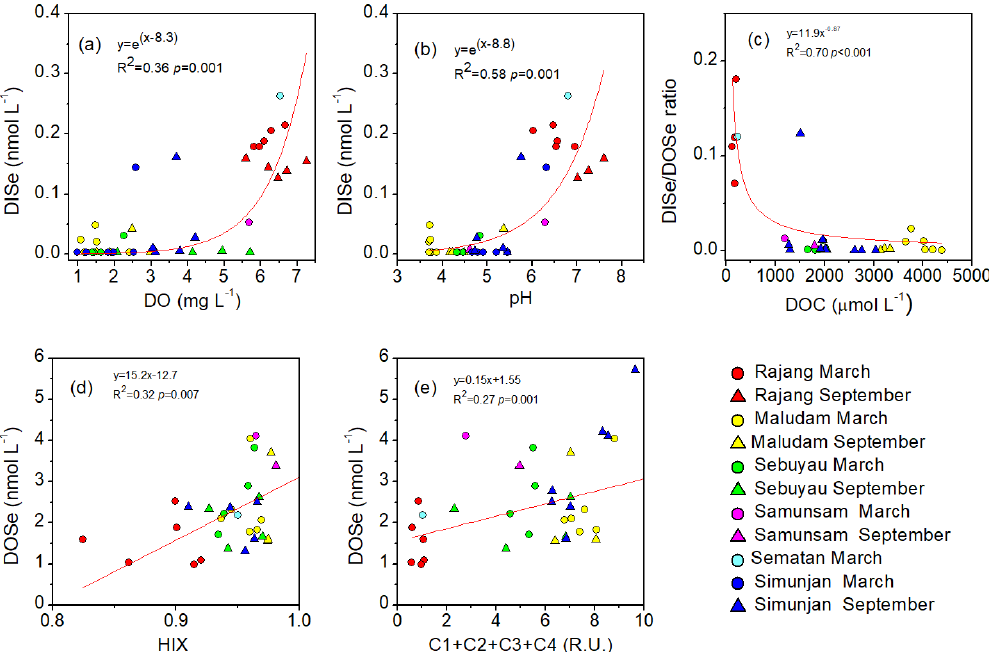
Figure 4. Relationships between (a, b) DISe concentrations and DO and pH values, (c) DISe / DOSe ratios and DOC concentration values, and (d–e) DOSe concentrations with the humification index (HIX) and the sum of humic-like CDOM components (C1, C2, C3 and C4) in freshwater (salinity < 1) for the Rajang, Sematan, Maludam, Sebuyau, Samunsam and Simunjan rivers in March and September. The HIX and C1, C2, C3, and C4 components are from Zhou et al. (2019) from the same cruises. DO concentrations and pH values were not available for the Sematan River for September, and the HIX and CDOM components were not available for the Rajang River for September.